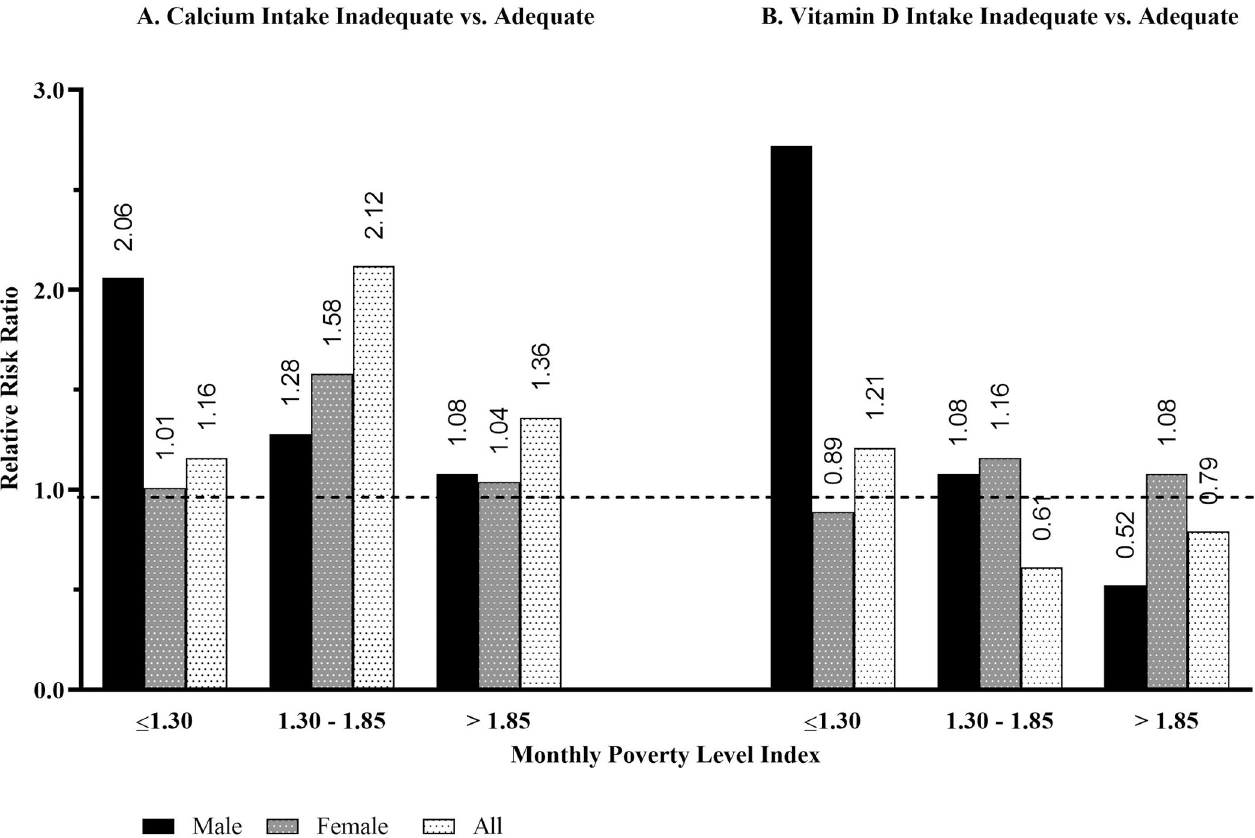
Fig 2. Relative risk of osteoporosis given monthly poverty level index category levels, age 50 and older.